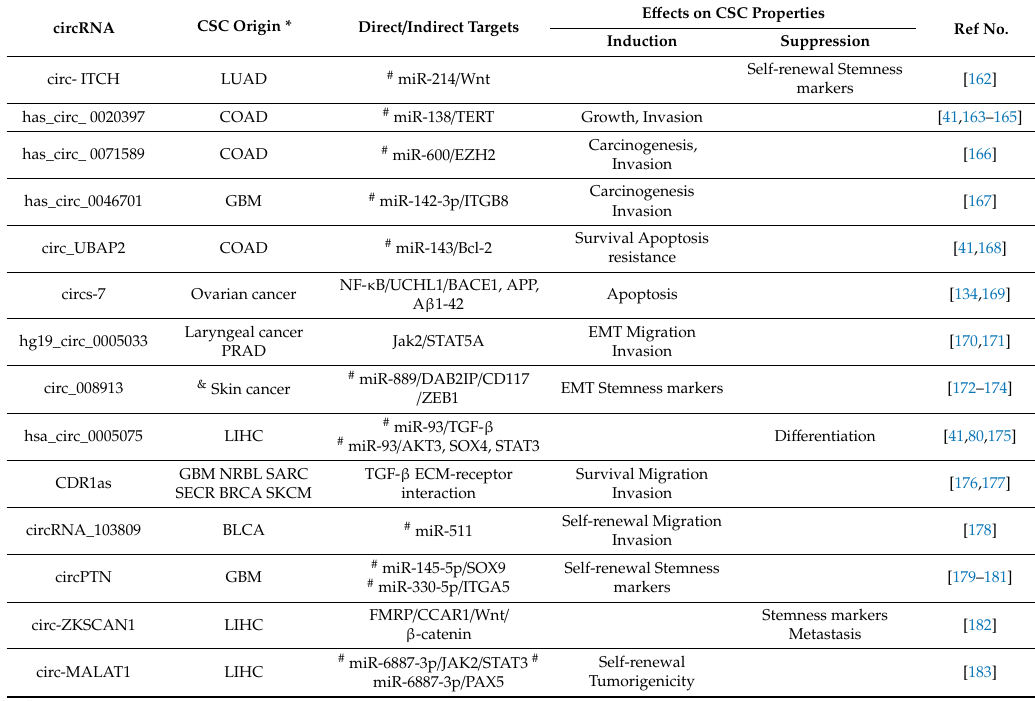
Table 3. Dual roles of circular RNAs (circRNAs) in the regulation of CSC-related features.